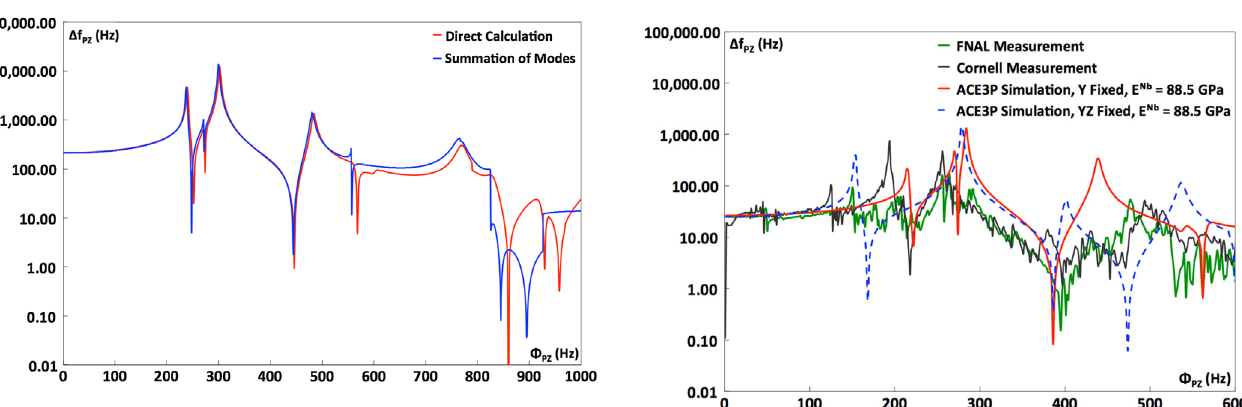
FIG. 12. Detuning magnitude as a function of the piezoactuator frequency Φ calculated directly from the structural deforma- PZ tions at each frequency (red) and by summing the modal response functions (blue).